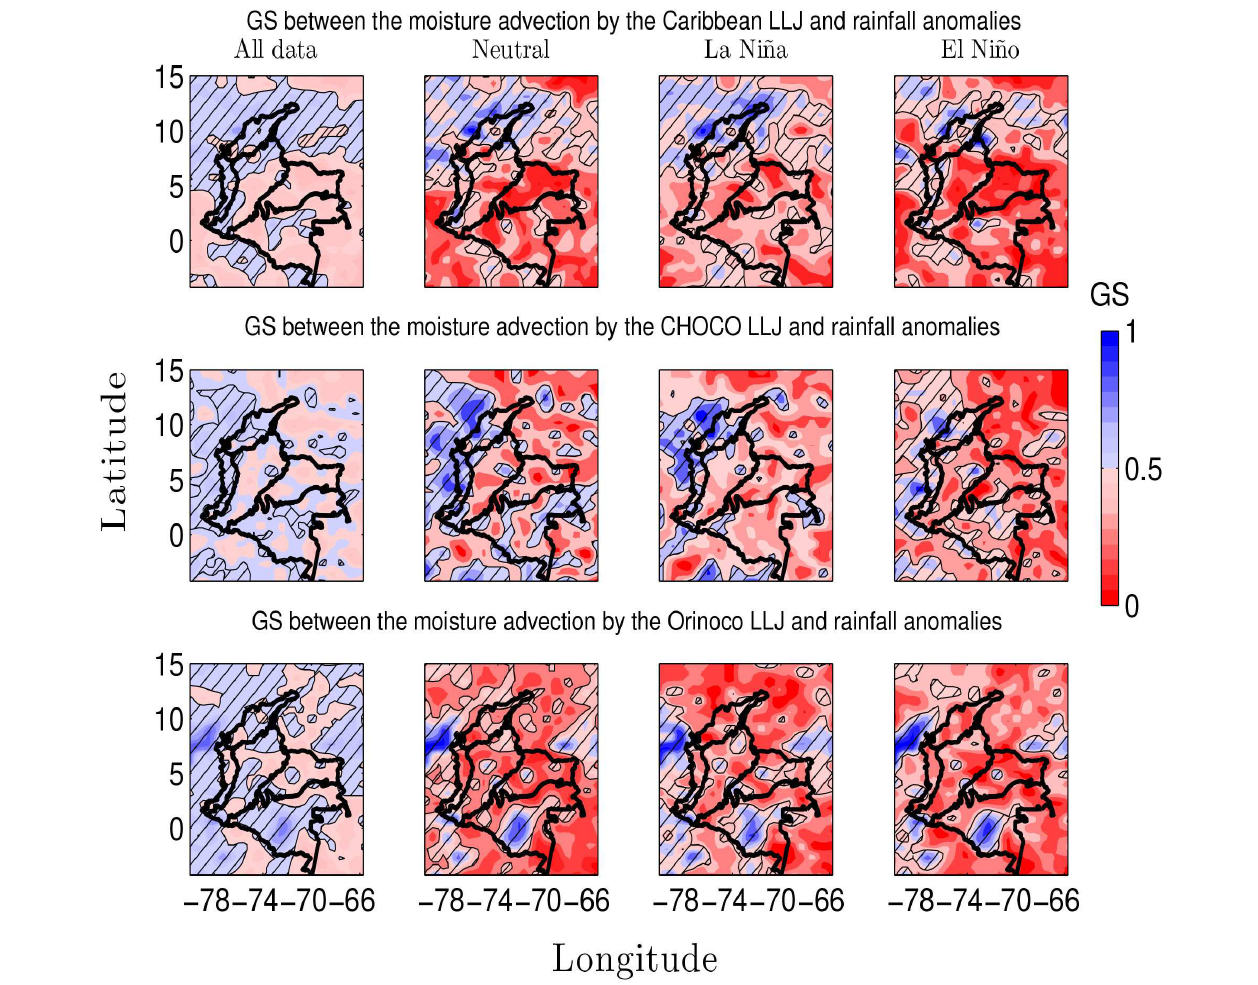
FIGURE 11 | Generalized synchronization index between the moisture advection of the low level jets and rainfall anomalies throughout Colombia. (Top row) Caribbean LLJ. (Middle row) CHOCO LLJ. (Bottom row) Orinoco LLJ. Dataset No. 1, period 1975–2006. The hatched contours indicates zones where the GS is significant at